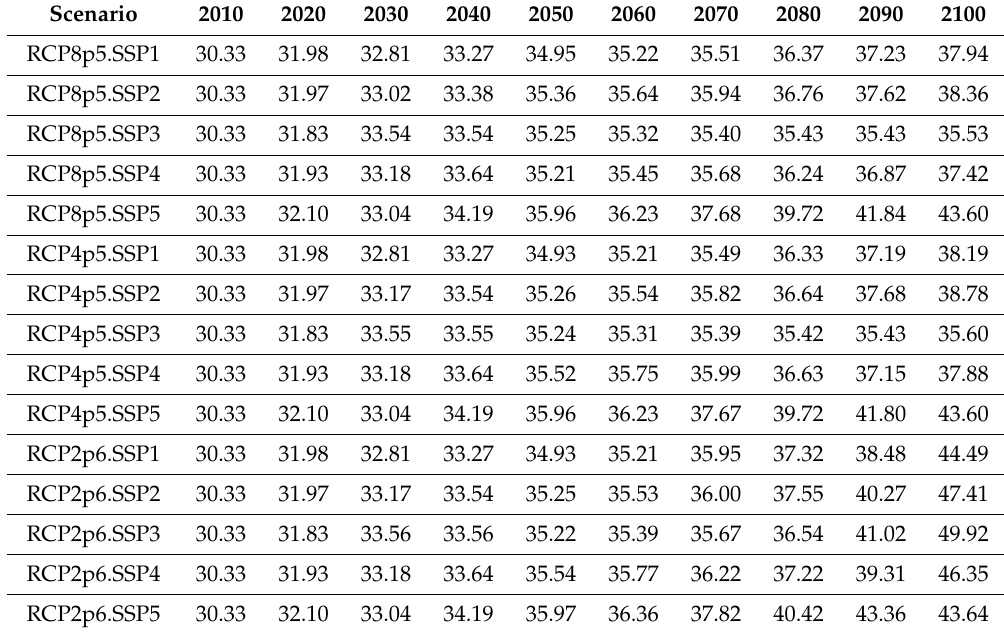
Table A4. Industrial roundwood harvest assortments—Pulpwood (millions of m 3 / year, under bark). Scenario